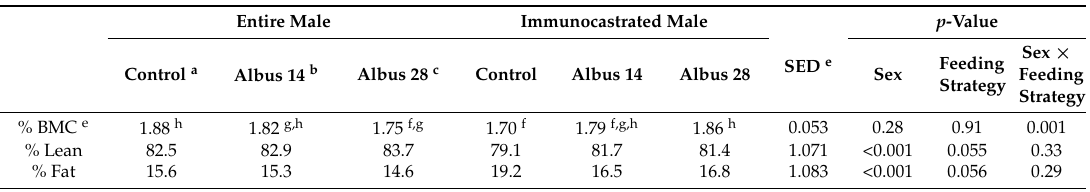
p -Value Sex × Feeding SED e Feeding Strategy Strategy